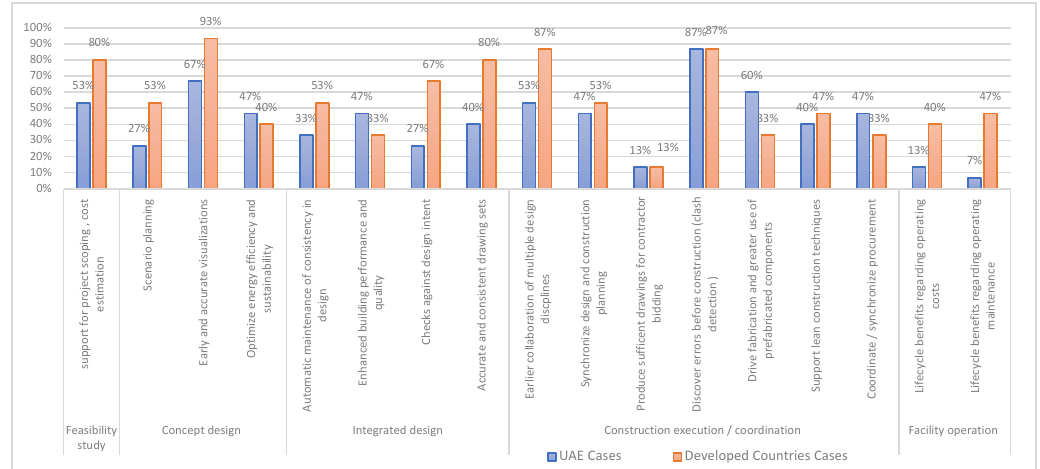
Figure 4. BIM benefits gained during the whole LC (BIM process).